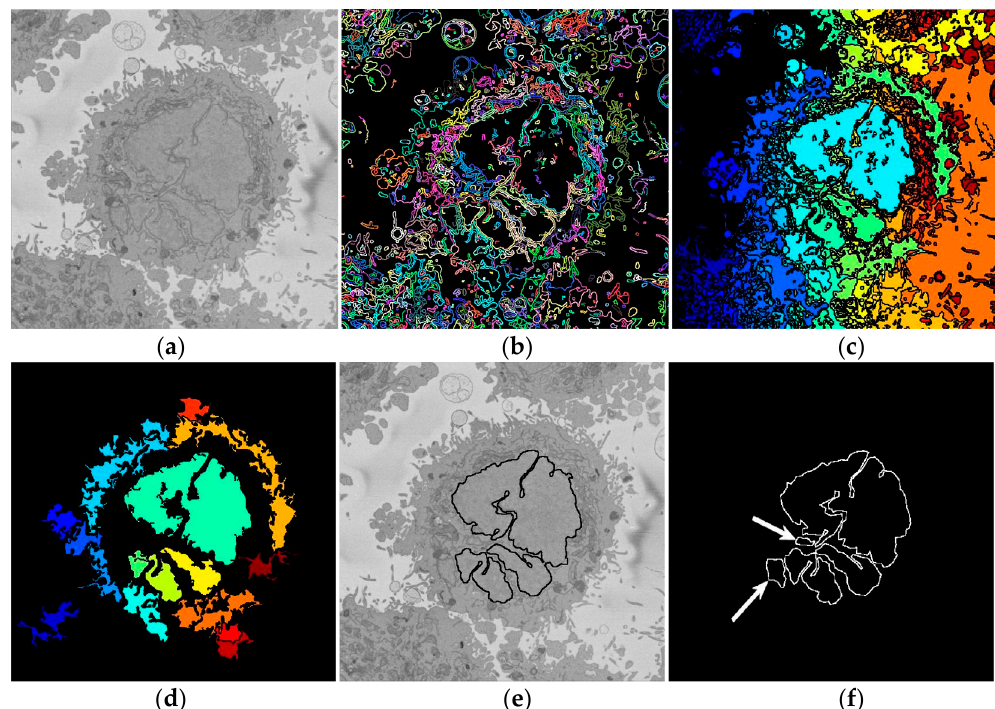
Figure 2. Intermediate steps of the segmentation algorithm. ( a ) Cropped region around one HeLa cell (dotted blue box in Figure 1c,f), surrounded by resin (background) and edges of other cells. This image was low-pass filtered. ( b ) Edges detected by Canny algorithm. The edges were further dilated to connect those edges that may belong to the nuclear envelope (NE) but were disjoint due to the variations of the intensity of the envelope itself. ( c ) Superpixels were generated by removing dilated edges. ( d ) Small superpixels and those in contact with the image boundary were discarded and the remaining superpixels were smoothed and filled, before discarding those by size that did not belong to the nucleus. ( e ) Final segmentation of the NE overlaid (thick black line) on the filtered image. ( f ) Ground truth (GT) manual segmentation of the same image. Regions not selected by the algorithm because of their sizes are highlighted with arrows. Notice that both the algorithm and GT detected disjoint regions.